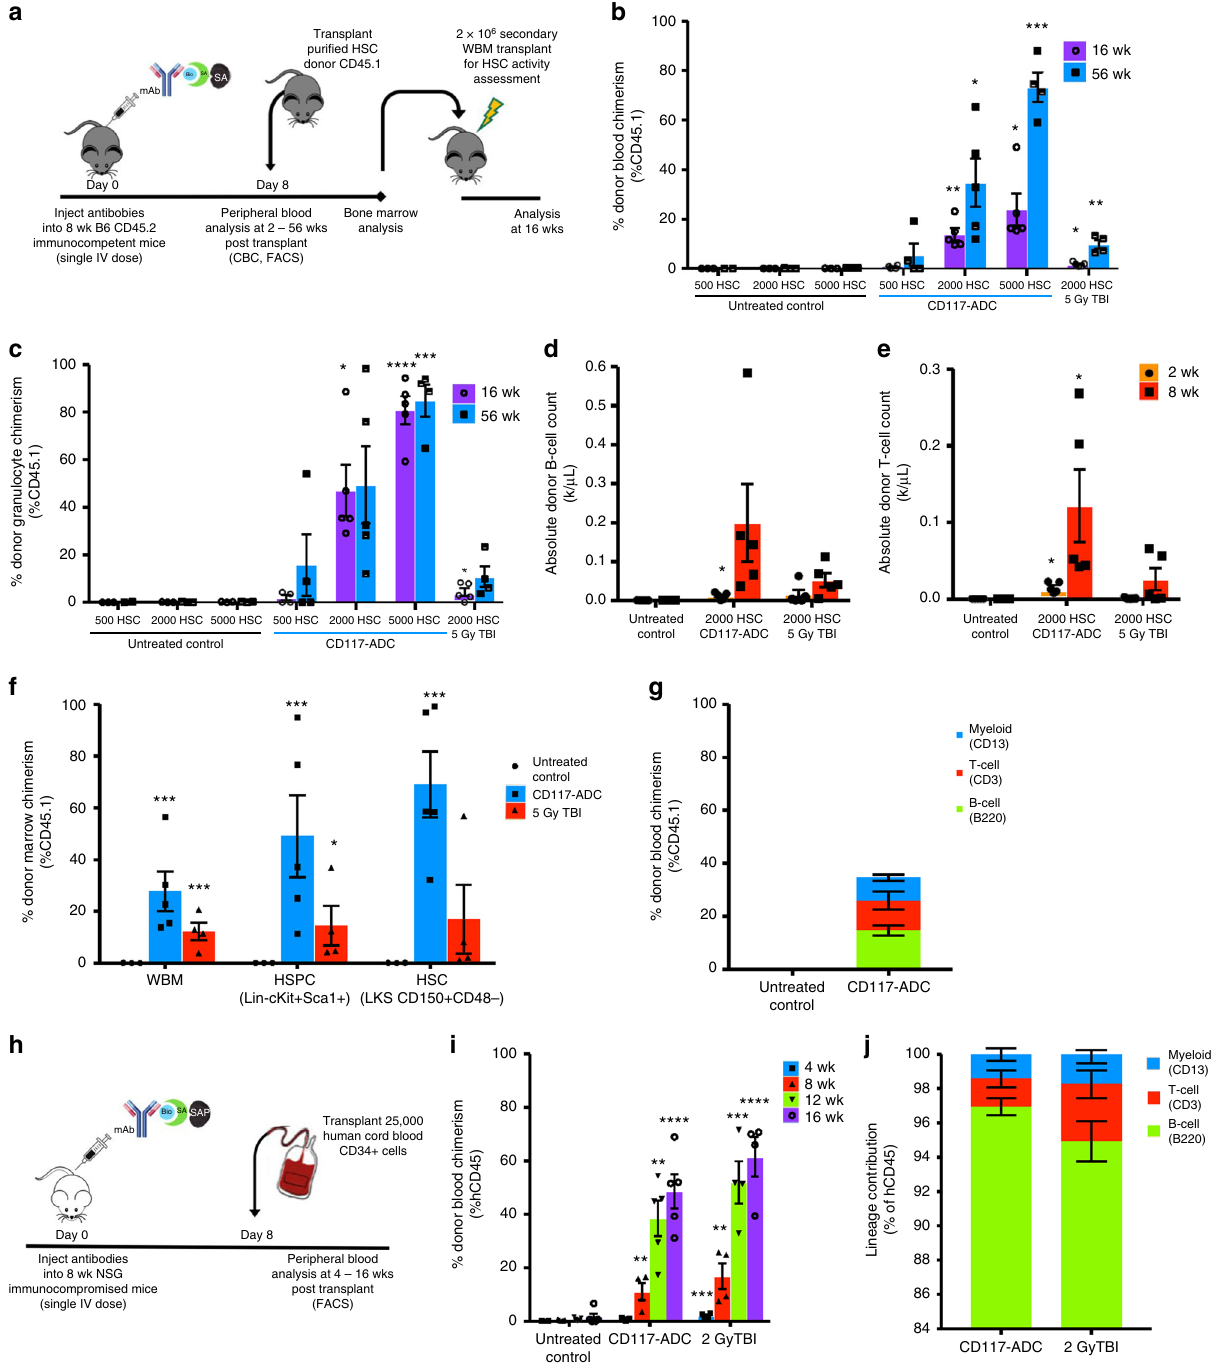
Fig. 4 CD117-ADC conditioning effectively enhances puri fi ed mouse and human HSC engraftment, with increased HSC cell dose resulting in increased multi- lineage reconstitution. a Experimental outline for assessing the ability of antibody-drug-conjugates to condition immunocompetent, wild-type C57BL/6 mice allowing for ef fi cient engraftment of donor murine HSC. b , c CD117-ADC pre-treatment 8 days before infusion of FACS-puri fi ed CD45.1 + donor HSCs leads to robust total donor peripheral blood ( b ) and donor granulocyte chimerism ( c ). Rapid donor B-cell ( d ) and T-cell ( e ) reconstitution post transplantation of puri fi ed HSCs into CD117-ADC-conditioned animals as compared to 5 Gy TBI controls. f Similarly enhanced donor HSPC (Lin − cKit + Sca + ) and HSC (Lin − cKit + Sca + CD150 + CD48 − ) chimerism post CD117-ADC treatment and transplantation of 2000 puri fi ed HSCs con fi rmed by phenotypic bone marrow analysis of transplanted animal 20 weeks post transplantation. g Donor HSC engraftment con fi rmed through secondary transplantation of WBM into lethally irradiated recipients. h Experimental outline for assessing the ability of antibody-drug-conjugates to condition immunocompromised, NSG mice for ef fi cient engraftment of donor human CD34 + cord blood cells. i Single treatment of CD117-ADC effectively enhances donor human cord blood HSPC engraftment in NSG mice, enabling creation of irradiation-free xenografts with multi-lineage reconstitution with total donor chimerism nearing similar levels as 2Gy TBI. j Multi-lineage human chimerism observed in all xenografted mice, with B-cell engraftment predominant regardless of the conditioning method. Data represent mean ±SEM ( n = 3 – 5 mice/group, assayed individually). Statistics calculated using unpaired t test; all data points signi fi cant as indicated vs. untreated control (* P < 0.05; ** P < 0.01; *** P < 0.001; **** P < 0.0001) NATURE COMMUNICATIONS| (2019) 10:617